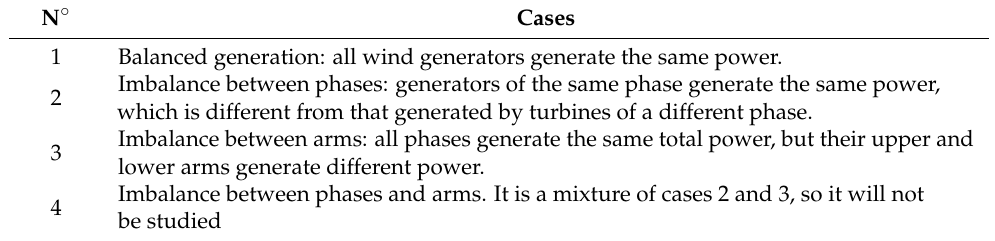
Table 3. Cases that can be found regarding the balance or imbalance between arms and phases.